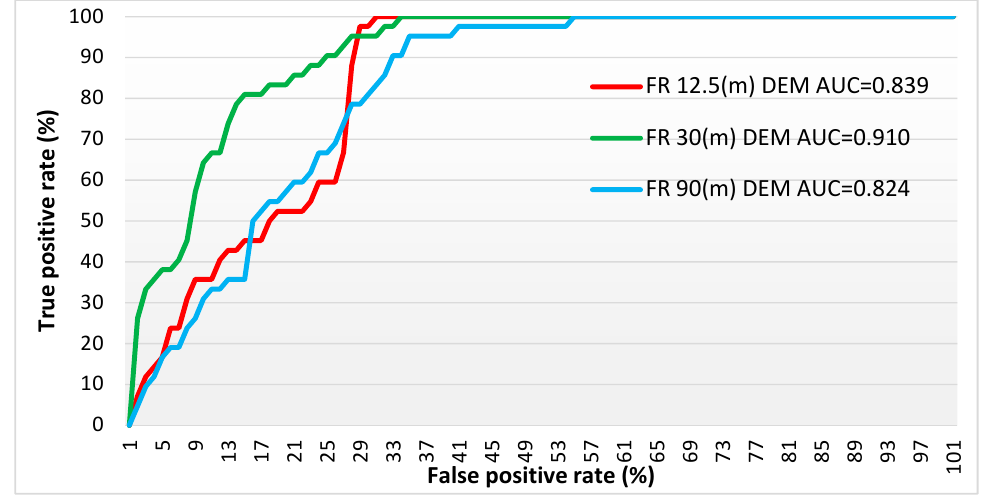
Figure 6. Receiver operating characteristic (ROC) curves representing success rate for the resulting maps from the three different resolution DEMs.